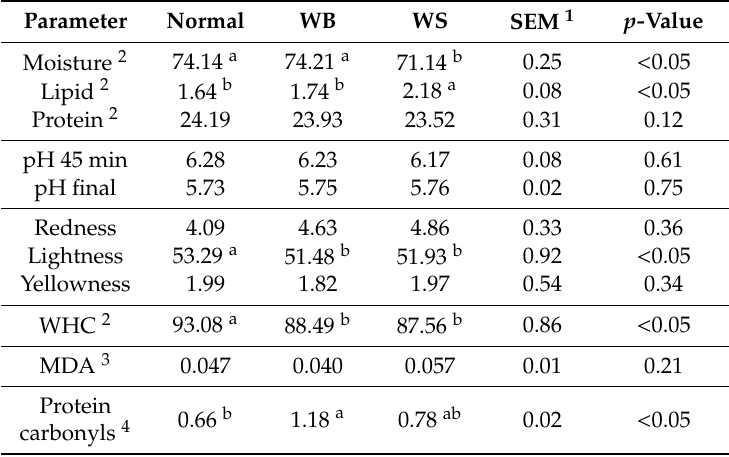
Table 7. Modifications of physicochemical properties in breast chicken muscles a ff ected by wooden breast (WB) and white striping (WS)